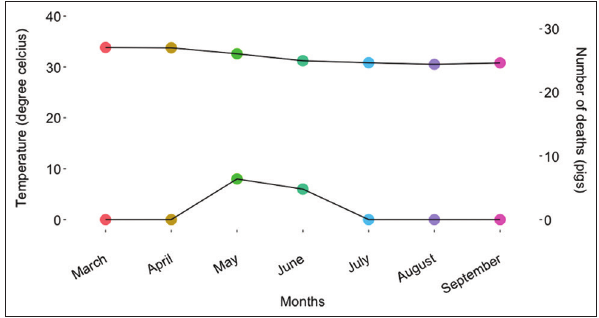
Figure-4: Association between observed death and monthly average temperature. No deaths were observed in March, April, July, and August. In the month of May, a total of 8 death incidents were observed and in June it was 6. The monthly average barn temperatures for these months were 32.59 and 31.22, respectively.